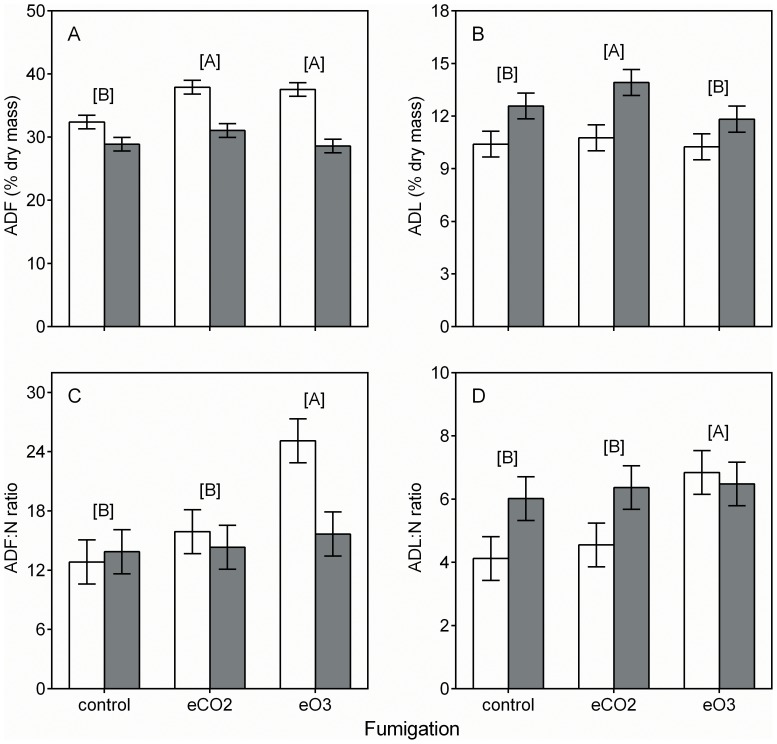
Fumigation and plant species effects on a) ADF, b) ADL, c) ADF:N, and d) ADL:N.White and gray bars indicate least square means ±SE (n = 3 replicate FACE rings for each group mean shown) for S. candensis and T. officinale, respectively. Figure format is as described for Figure 1.